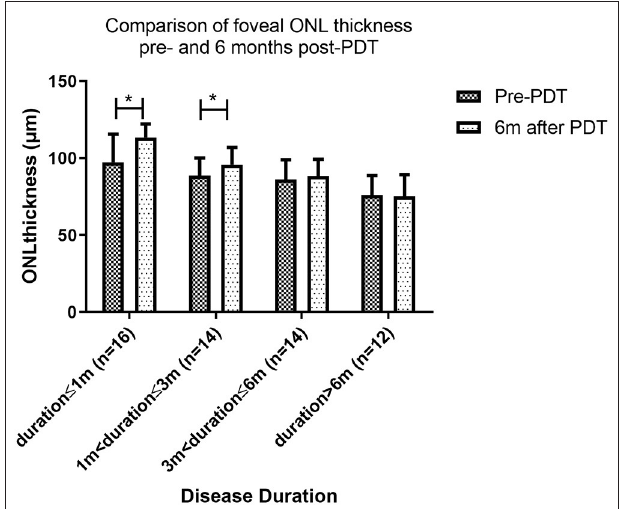
FIGURE 4 | Comparison of foveal ONL thickness pre- and 6 months post-PDT. Patients with a disease duration of less than 1 month had the best ONL recovery, followed by those with a disease duration of 1 to 3 months. Even if the subretinal fluid was totally absorbed, ONL could not be retrieved in patients with a disease duration of more than 3 months (* indicates statistical significance).